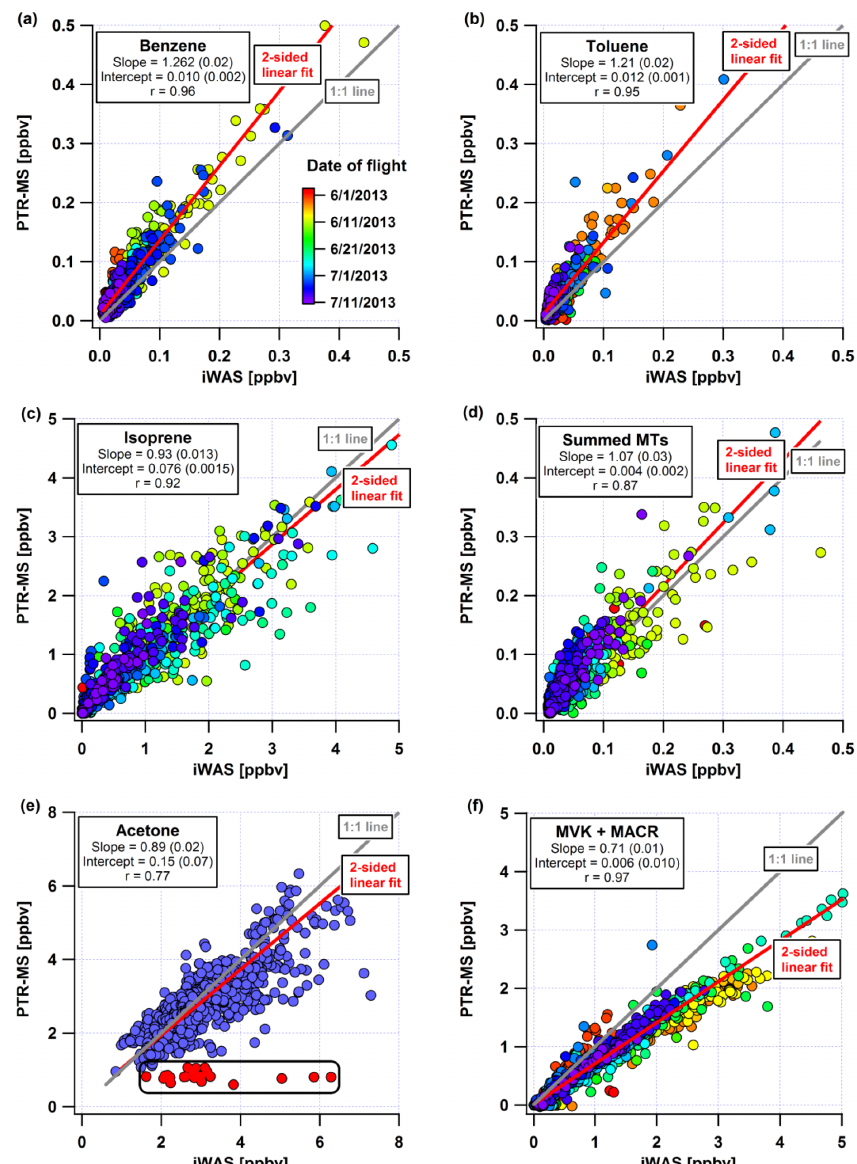
Figure 10. Intercomparison with PTRMS of select VOCs from SENEX 2013. Slopes and intercepts from two-sided linear fits of the data are presented, along with correlation coefficients ( r ) from one-sided linear fits. The red points circled in (e) show data collected in dry canisters during a test flight from Tampa, FL, and are not used for the linear